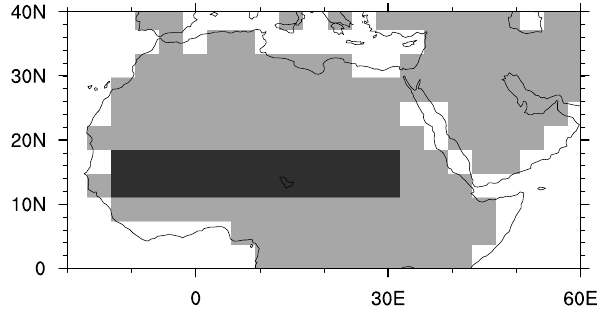
Fig. 2. Region of analysis. The dark-grey grid boxes are those de- fined as the Sahel in this study. Light grey indicates land and white indicates